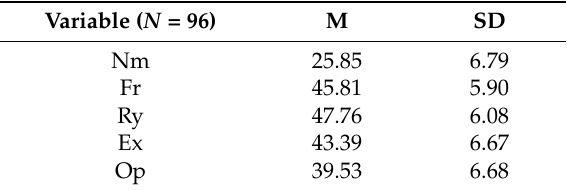
Table 1. Descriptive analysis of the variables related to personality.